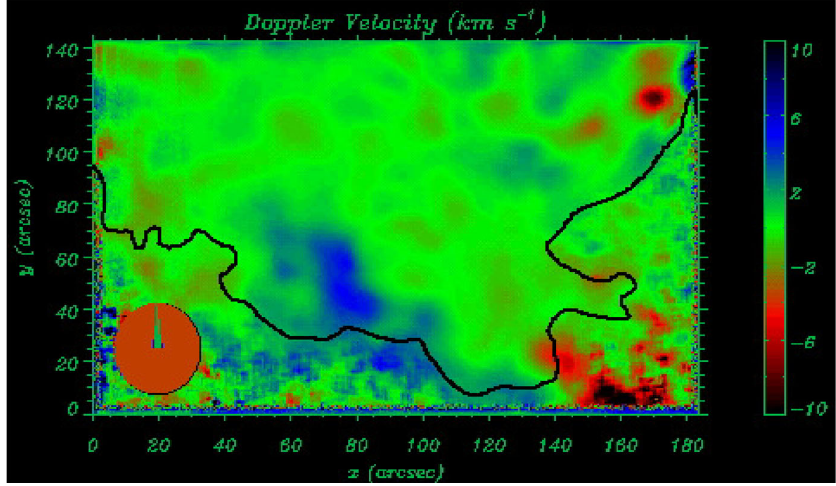
Fig. 22 Still from a movie showing the temporal evolution of the Doppler velocity in all points of the field of view of Fig. 21. (To watch the movie, please go to the online version of this review article at